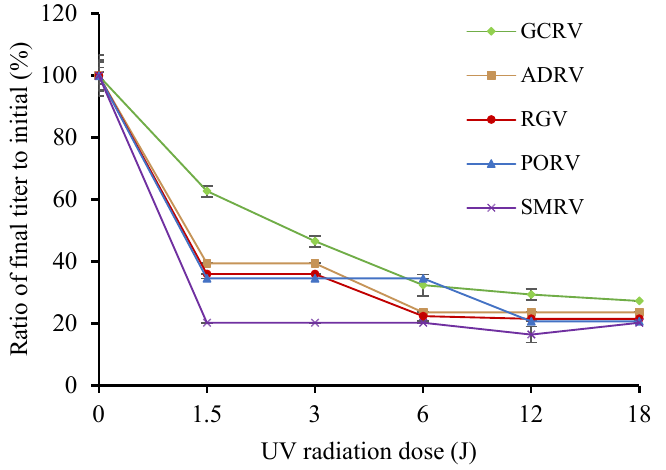
Figure 1. Effect of UV dose on titers of RGV, ADRV, PORV, SMRV, and GCRV. Each point in the figure showed the ratio of the titer after UV radiation treatment to initial titer for each virus.